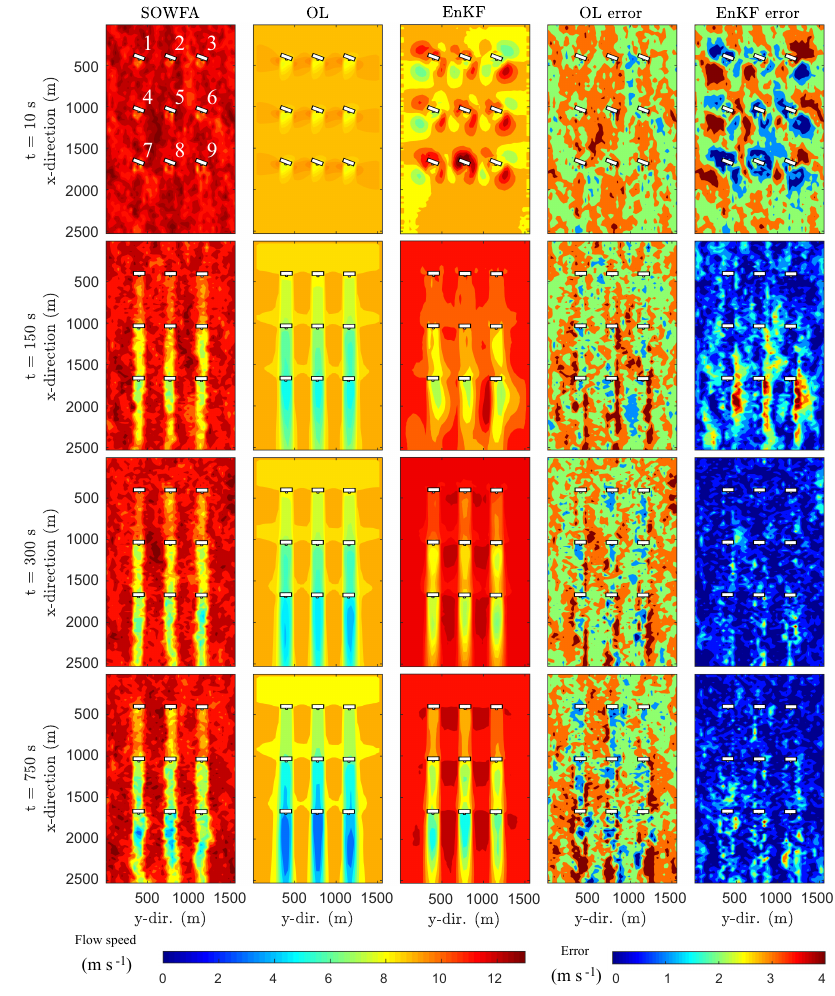
Figure 8. Comparison of absolute values of the estimation errors (in long. flow fields) for state-parameter estimation with the EnKF. Wind is coming in from the top and flows downwards. The variables U ∞ and (cid:96) s are incorrectly initialized in both the OL and the EnKF. In the EnKF, U ∞ and (cid:96) s are estimated in addition to the states, using only turbine power measurements. The EnKF quickly converges for the states, and more slowly for (cid:96) s and U ∞ . After 300s, the EnKF has converged to a negligible estimation